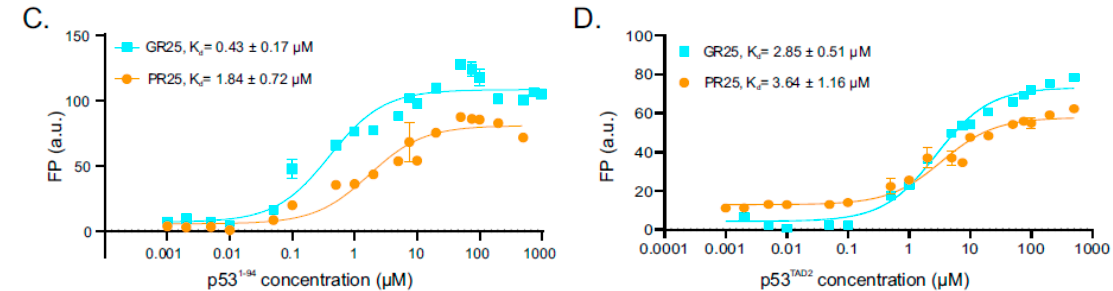
Figure 2. TAD2 is sufficient for binding to PR25/GR25. ( A ) 1 H- 15 N HSQC spectrum of 15 N-labeled p53 TAD2 at 50 µ M in the absence (black) and presence of one stoichiometric equivalent of GR25 (cyan; upper panel). Corresponding CSPs are shown in a bar-plot in the bottom panel; ( B ) 1 H- 15 N HSQC spectrum of 15 N-labeled p53 TAD2 at 50 µ M in the absence (black) and presence of one stoichiometric equivalent of PR25 (orange; upper panel). Corresponding CSPs are shown in a bar-plot at the bottom panel. Unassigned residues are indicated in grey; ( C ) Fluorescence polarization (FP) measurements of fluorescein isothiocyanate (FITC)-labeled GR25 (cyan) or PR25 (orange) with increasing concentrations of p53 1 − 94 . K d values are shown and were calculated by assuming a 1:1 complex formation. Graph represents the mean of three experiments and the reported errors correspond to the SD of the fit; ( D ) FP measurements of FITC-labeled GR25 (cyan) or PR25 (orange) with increasing concentrations of p53 TAD2 . K d values are shown and were calculated by assuming a 1:1 complex formation. Graph represents the mean of three experiments and the reported errors correspond to the SD of the